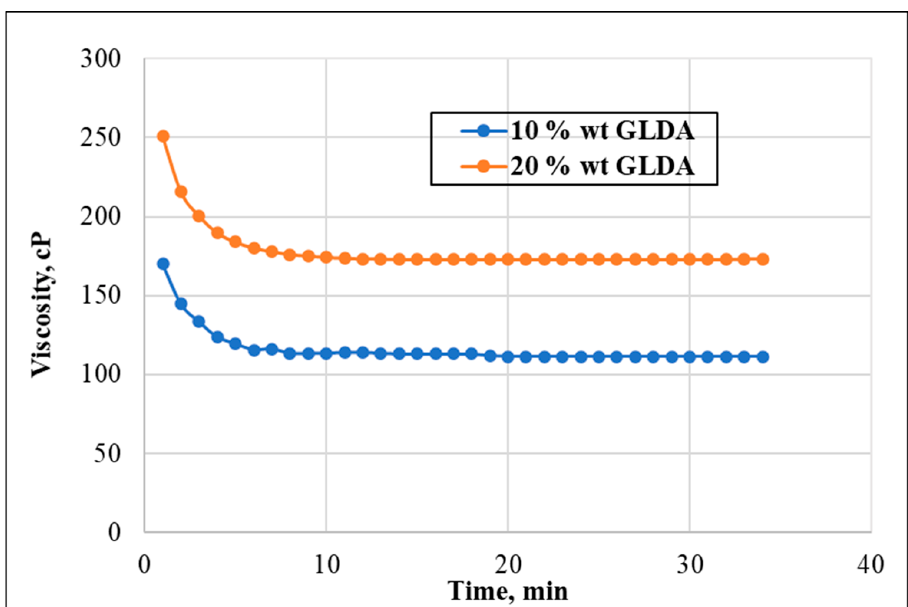
Figure 6. Effect of GLDA concentration on the viscosity (shear rate= 100 s − 1 , temperature= 150 °F, pH = 8, and CMHPG concentration= 50 pptg).